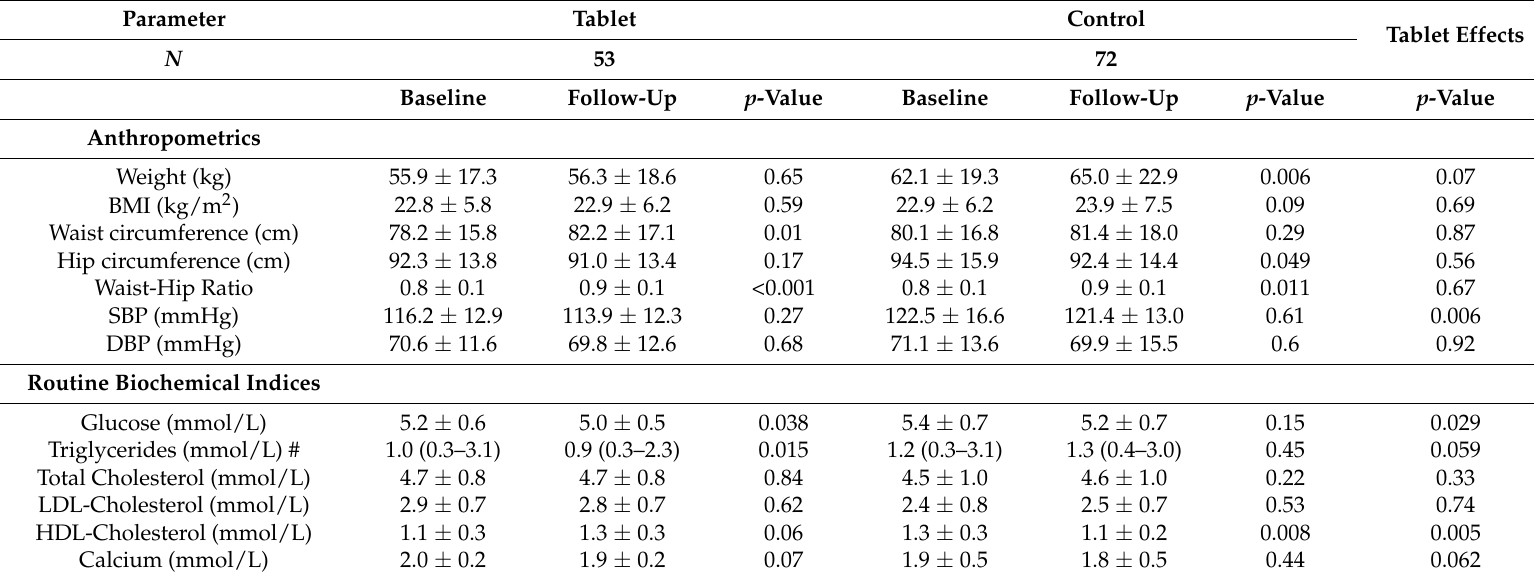
Table 2. Changes in anthropometric and clinical parameters at baseline and follow-up.